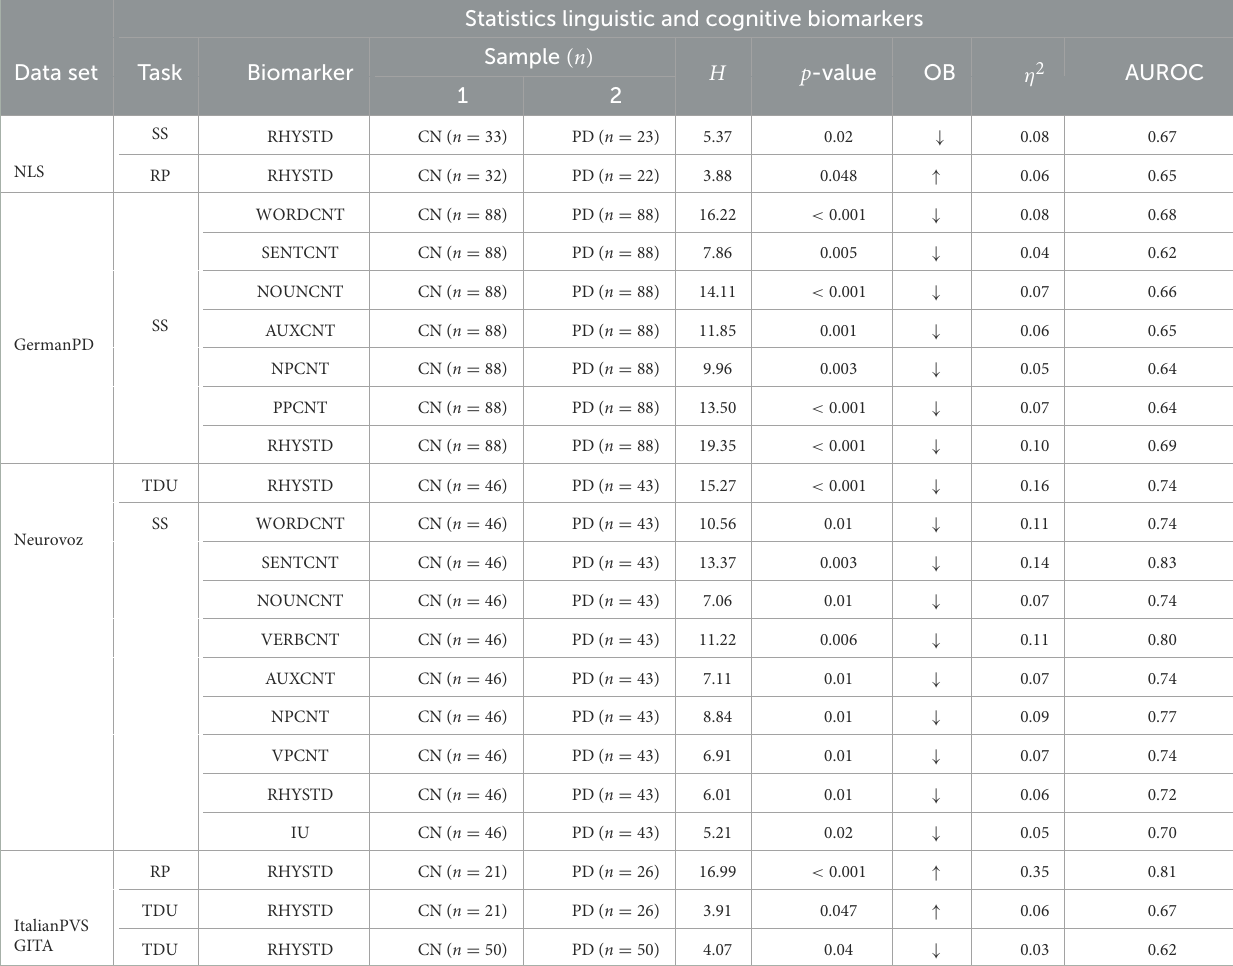
TABLE 6 Pairwise Kruskal–Wallis H -test results for the linguistic and cognitive biomarkers that were statistically significant ( p < 0.05) in the TDU, RP, and SS tasks, respectively, within the six data sets